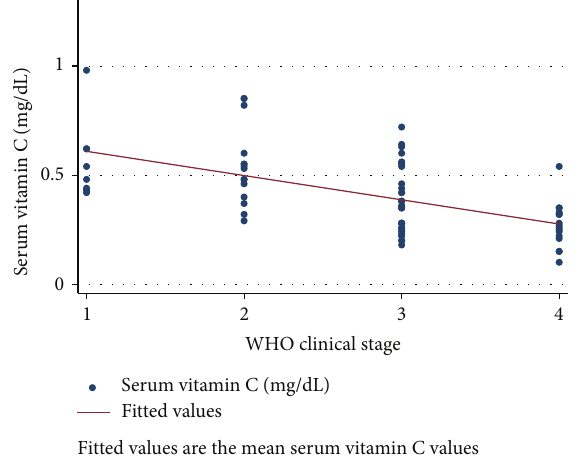
Figure 3: The relationship between serum vitamin C levels and clinical stage of HIV infected subjects.